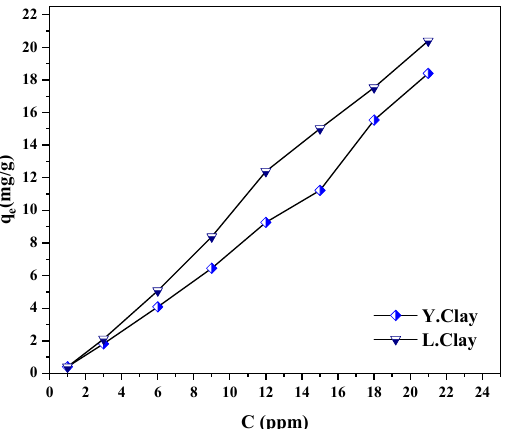
Figure 7. Effect of Initial Dye Concentration; Conditions: t = 10 min for Y. Clay/15 min for L. Clay,